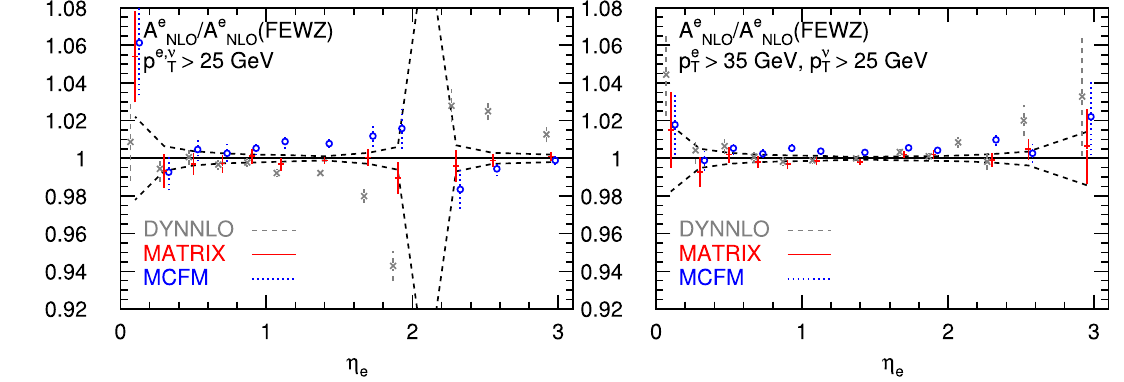
≥ 25 GeV symmetric T